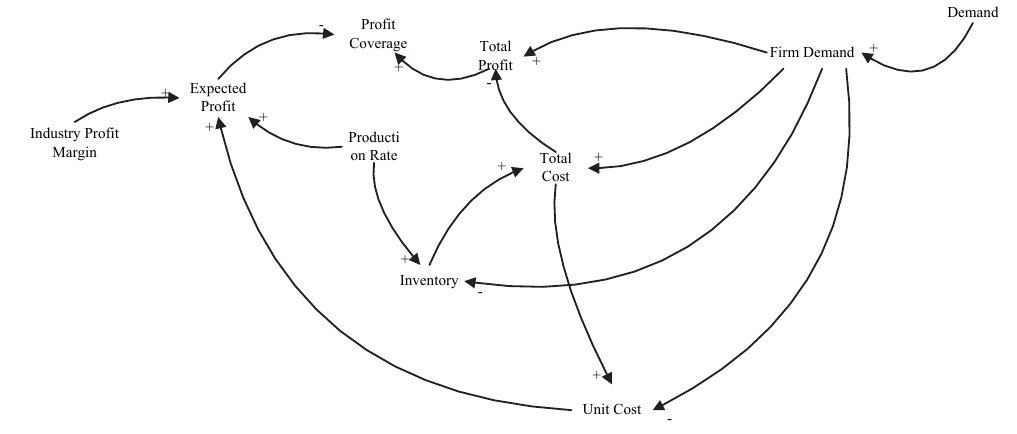
Fig. 4. The cause and effects of demand of each firm on profit (loss) in an oligopoly